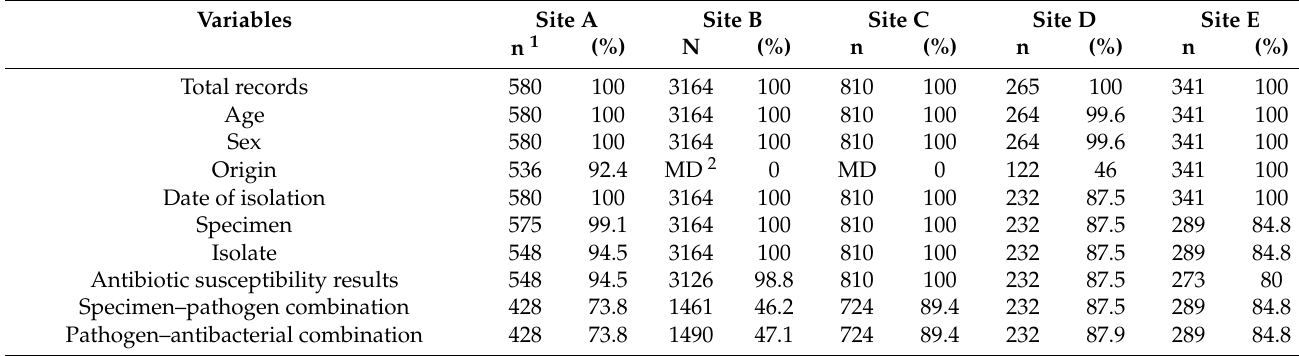
Figure 1. Consistency of specimen–pathogen combination according to the GLASS from five AMR surveillance sites in Province 3 of Nepal (January to June 2019). When the AMR surveillance records at the sites were compared to records sent to the NPHL, there was completeness overall, except for a variable origin (hospital or community), which were missing data at two of the sites (sites B and C) and incomplete at two more (94% at Site A and 53% at Site D). For Site B, the antibiotic susceptibility, specimen–pathogen combination, and pathogen–antibacterial combination data were all incomplete (99.7%, 96.9%, and 97.9%, respectively) (Table 1). Table 1. Completeness of AMR surveillance data from five AMR surveillance sites in Province 3 of Nepal (January 2019–June